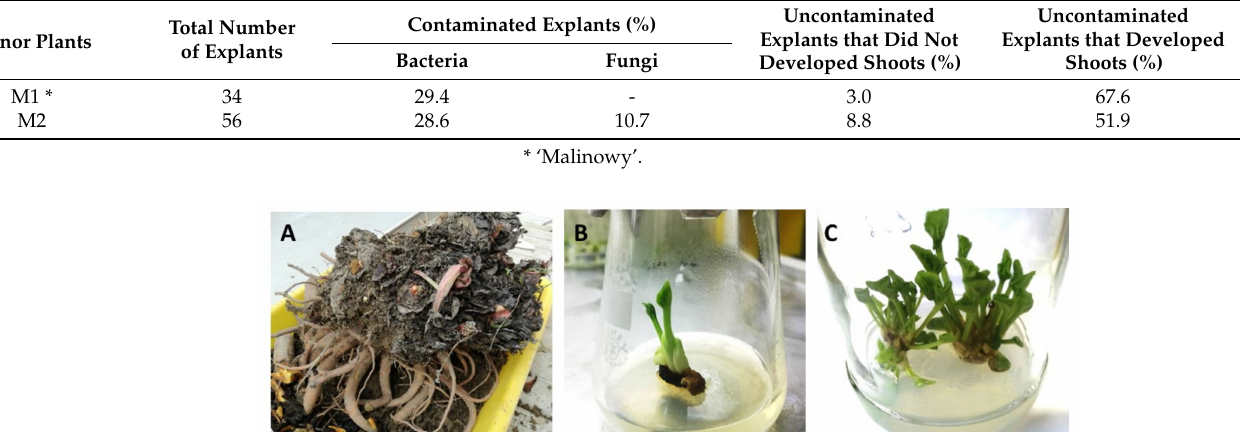
Table 1. Effect of mother (donor) plants on contamination of initial explants of Polish rhubarb ‘Malinowy’ in vitro. Donor Plants